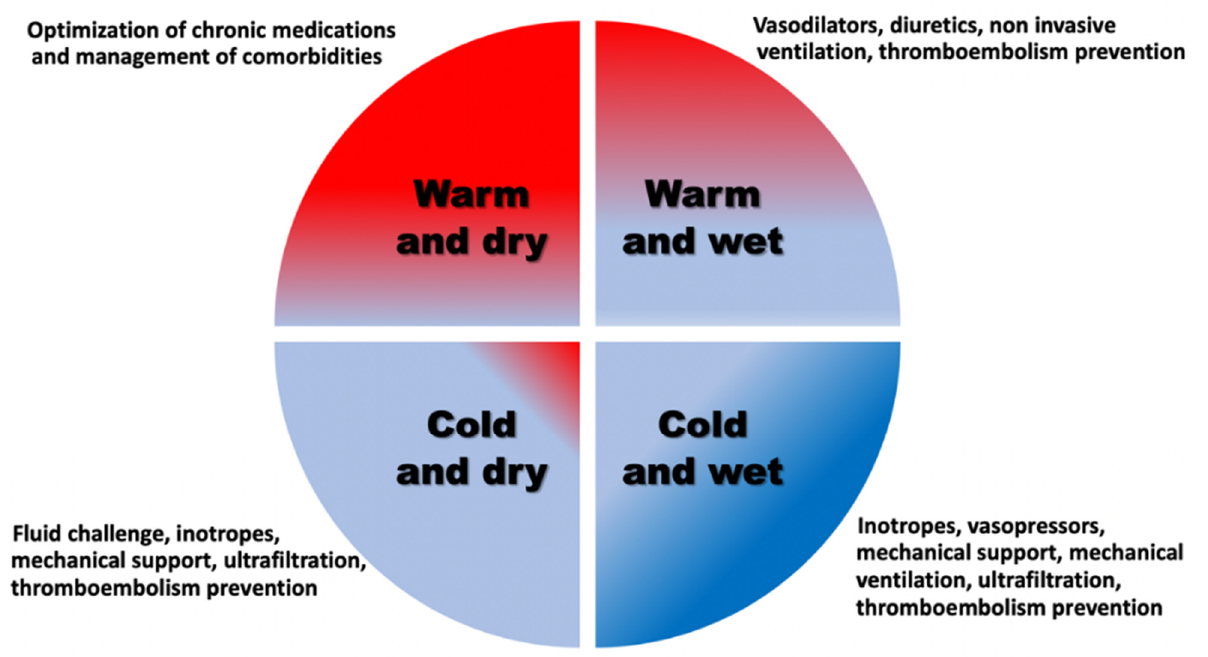
Figure 2. Protection of brain function through the optimal management of acute heart failure clinical profile.